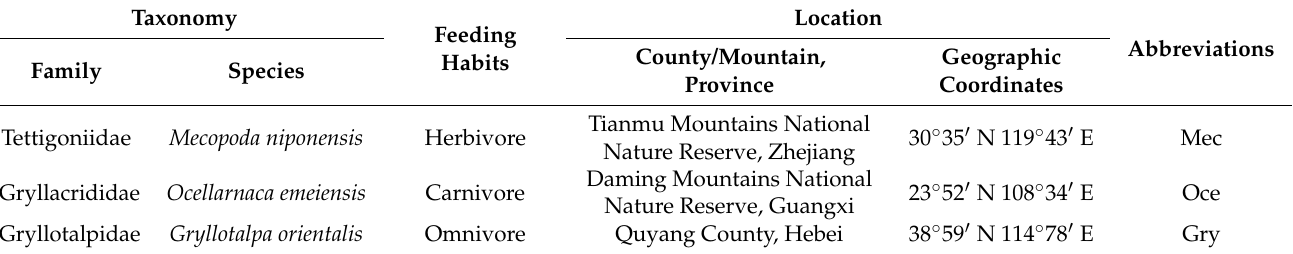
Table 1. Overview of sample